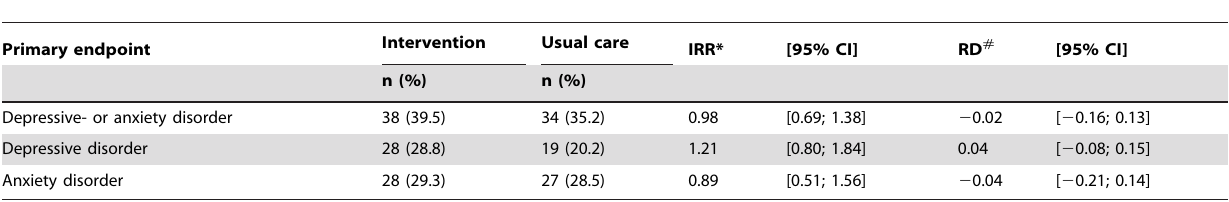
Table 2. Incidence of depressive and anxiety disorders over 12 months follow-up.